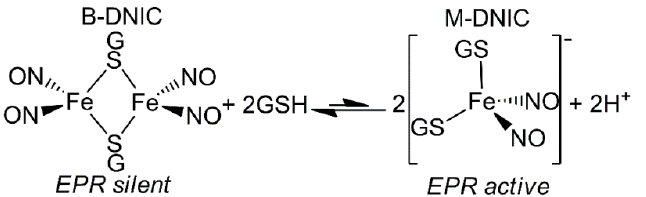
Figure 4. Kinetics of S-denitrosation of Prx1 by GSH. ( a ) Representative kinetics of spontaneous denitrosation (blue trace) and denitrosation mediated by GSH (400 μ M) (black trace) for nitrosated Prx1 (5 µM); ( b ) representative kinetics of reduced wild-type Prx1 (5 µM) nitrosation by GSNO (400 μ M) ( λ exc = 280 nm; λ em > 320 nm) (Photophysics SX-18MV stopped-flow spectrometer). The red trace corresponds to the fitting of the data to a double-exponential function (right panel) and to a single- exponential function (left panel). ( c ) Determination of the second-order rate constant of the reaction of Prx1-Cys 52 NO with GSH. The determined pseudo-first-order rate constants ( k obs ) were plotted against GSH concentration and the second-order rate constant obtained from the slope. All the experiments were performed phosphate buffer (50 mM) containing DTPA (0.1 mM), pH 7.4, at 25